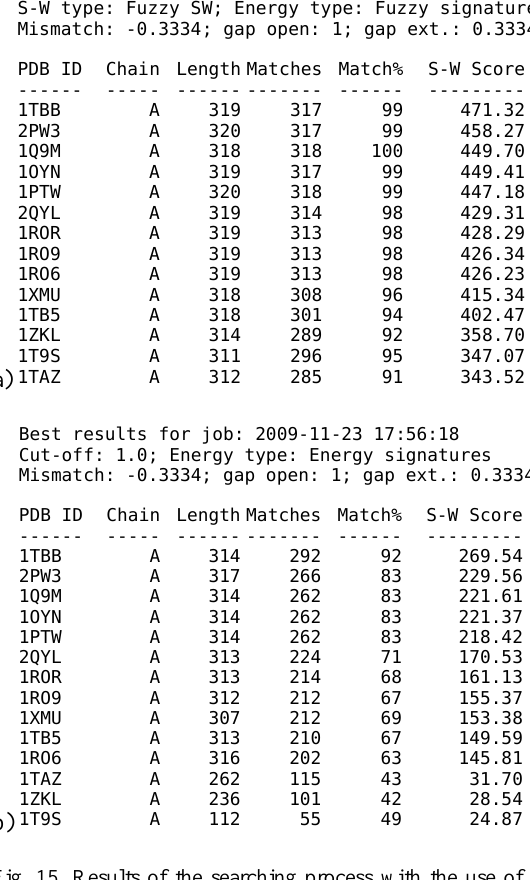
Fig. 15. Results of the searching process with the use of the new FS-EAST algorithm (a) and its predecessor EAST (b) executed for the molecule 1TB7 (Human Phosphodiesterase 4D with the AMP).